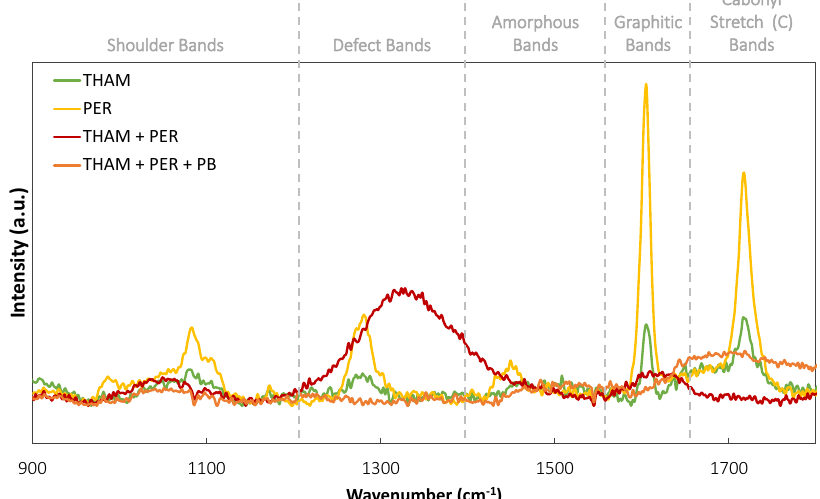
Fig. 8 Char Raman analysis. Raman spectra of 14 BL fi lms after torch testing, showing de fi nitive differences in the charring exhibited by the samples containing THAM (green), PER (yellow), THAM + PER (red), and THAM + PER + PB